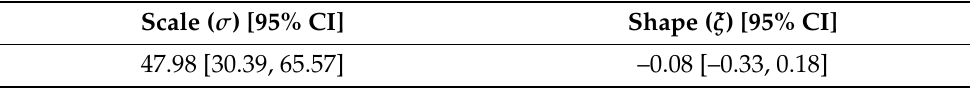
Table 3. Estimates and their 95% CIs of two GP parameters obtained by bootstrapping.